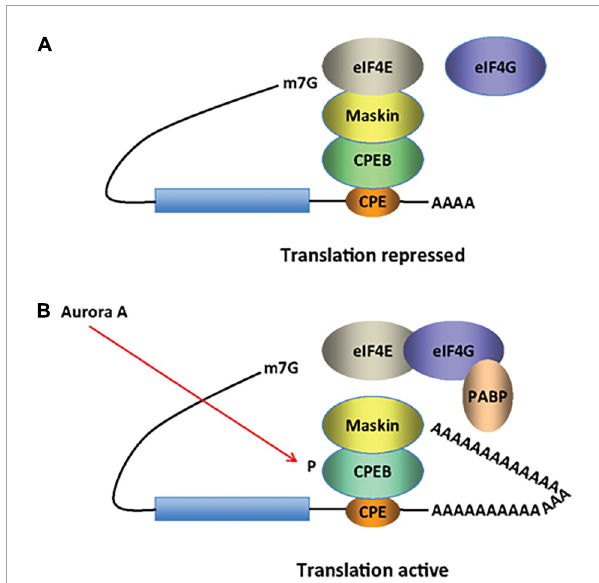
FIGURE5 CPEB activity in inducing cytoplasmic shortening or elongation of poly(A)-tails. Some mRNAs contain a cytoplasmic polyadenylation element (CPE), which is bound by CPEB. (A) CPEB also interacts with Maskin (or Neuroguidin, a functionally related protein), which in turn interacts with the cap (m7G) binding protein eIF4E. Such mRNAs are translationally inactive because Maskin inhibits the association of eIF4E and eIF4G, another initiation factor that helps recruit the 40S ribosomal subunit to the 5’ end of the mRNA. (B) Cues such as NMDA receptor activation stimulate the kinase Aurora A, which phosphorylates CPEB, an event that causes poly(A) tail elongation. poly(A) binding protein (PABP) binds the newly elongated poly(A) tail and recruits eIF4G. The PABP-eIF4G dimer helps to displace Maskin from eIF4E, allowing eIF4G to bind eIF4E and initiate translation [figure modified from Zukin et al. (2009), obtained under a creative commons license 3 and